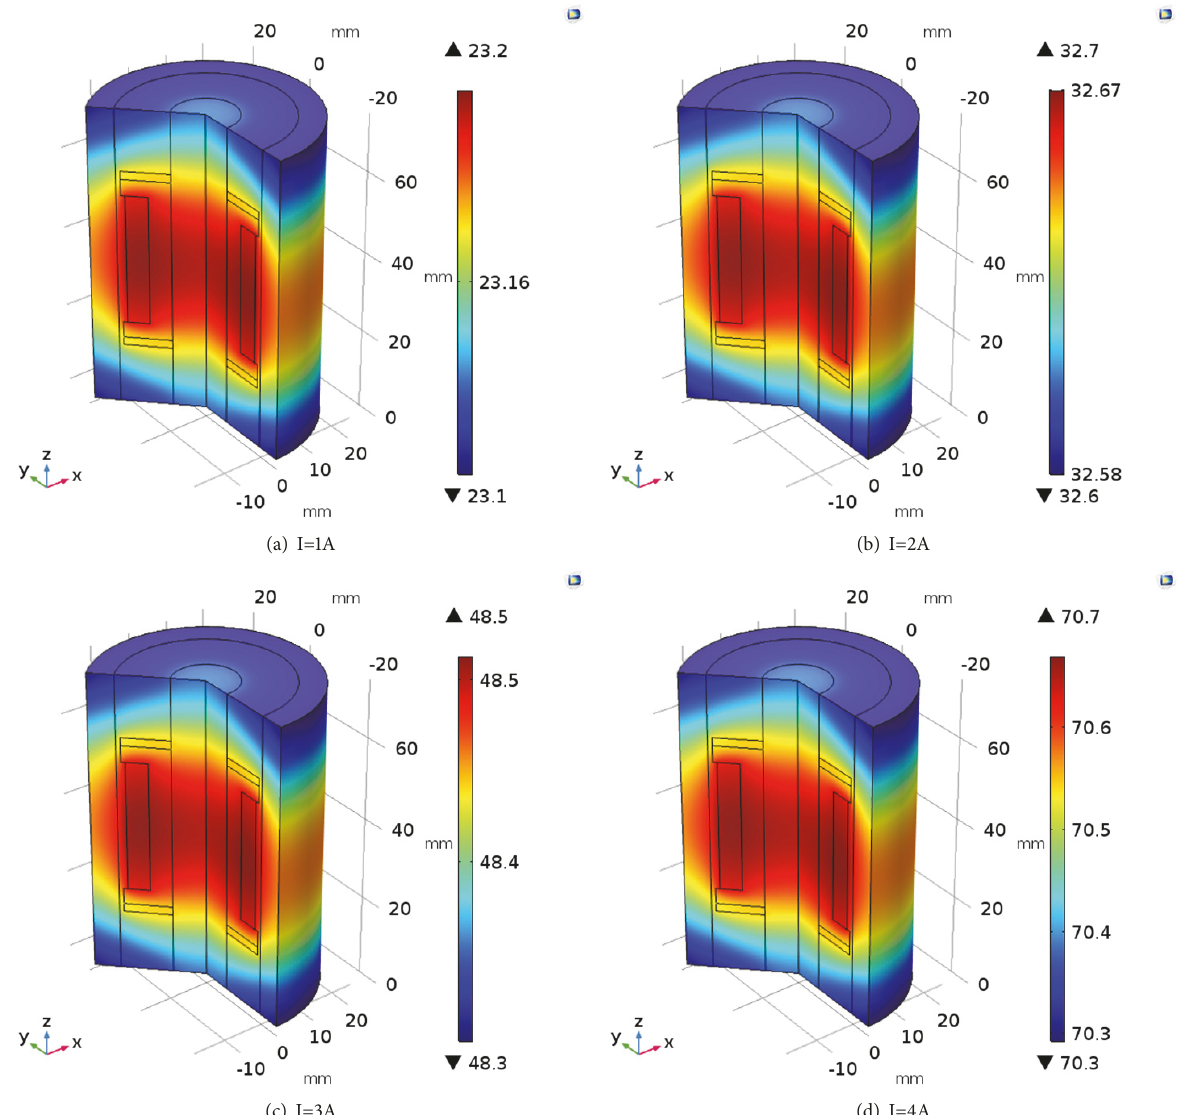
Figure 16: Heat distribution in the MRF damper with